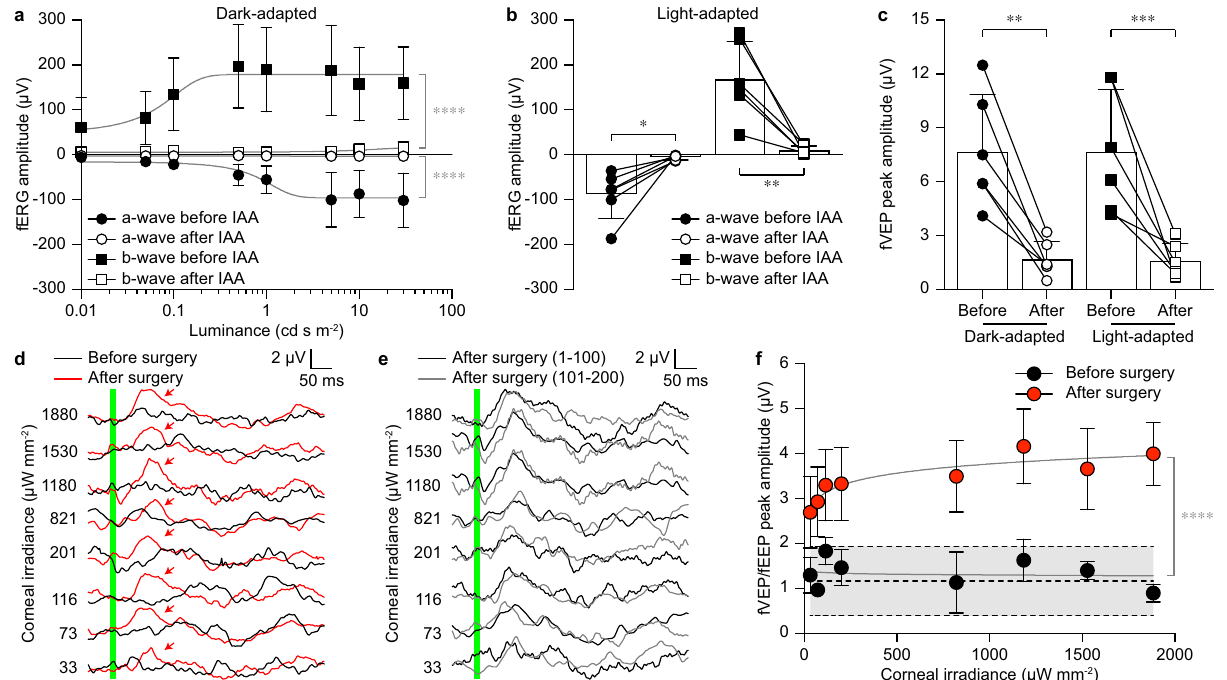
Fig. 7 Functional validation of POLYRETINA in blind minipigs. a Quanti fi cation of the dark-adapted fERGs in IAA-treated minipigs before and after IAA administration (mean ± s.d., n = 6 eyes from N = 3 minipigs). Grey lines are the logistic growth regressions (a-wave before: R2 = 0.49543; a-wave after: R2 = 0.0231; b-wave before: R2 = 0.2587; b-wave after: R2 = 0.1300). Extra sum-of-squares F test; p < 0.0001 (****) for both a-wave and b-wave. b Quanti fi cation of the light-adapted fERGs before and after IAA administration (mean ± s.d., n = 6 eyes from N = 3 minipigs). Two-tailed paired t -test; a- wave: p = 0.0138 (*) and power 0.98; b-wave: p < 0.0053 (**) and power 1.00. c Quanti fi cation of the dark-adapted and light-adapted fVEPs in IAA-treated minipigs before and after IAA administration (mean ± s.d., n = 6 eyes from N = 3 minipigs). Two-tailed paired t -test; dark-adapted: p = 0.0012 (**) and power 1.00; light-adapted: p = 0.0008 (***) and power 0.99. d fVEPs and fEEPs were recorded immediately before (fVEPs, black) and immediately after (fEEPs, red) POLYRETINA implantation at increasing irradiance levels at the cornea. The green bar corresponds to the 10-ms long light pulse. Red arrows show the peak responses with POLYRETINA. e fEEPs recorded after POLYRETINA implantation were obtained from d by averaging two blocks of 100 consecutive responses. The green bar corresponds to the 10-ms long light pulse. f Quanti fi cation of the peak-to-peak amplitudes as a function of corneal irradiance before (black, fVEP) and after (red, fEEP) POLYRETINA implantation (mean ± s.d., n = 3 eyes from N = 3 minipigs). The grey area between dashed lines corresponds to the mean (±s.d.) biological noise obtained in each minipig from control trials without light stimulation. Grey lines are the semi- log regressions (before surgery: R2 = 0.0067; after surgery: R2 = 0.2847). Extra sum-of-squares F test; p < 0.0001 (****). Data in panels a – c , f are from MP9 – 11. Data in panels d , e are from MP9. Source data are provided as a Source Data fi